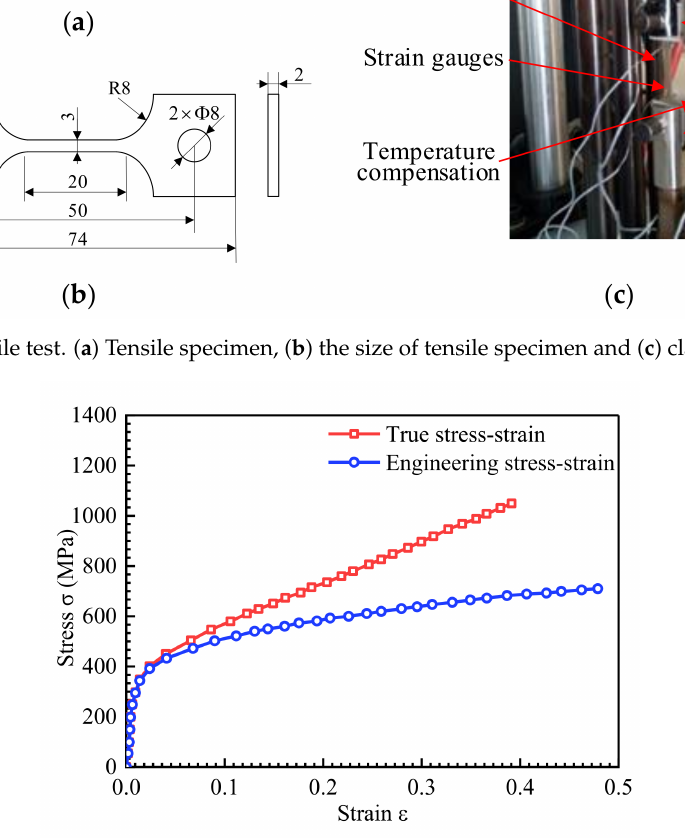
Figure 7. Stress–strain curve of 306 stainless